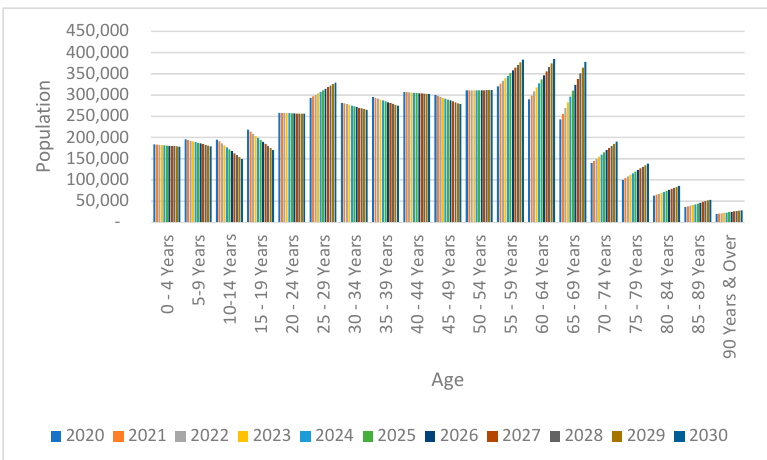
Figure 3. Projection of Singapore Residents by Age Group: 2020 to 2030. Source: Developed for the study.